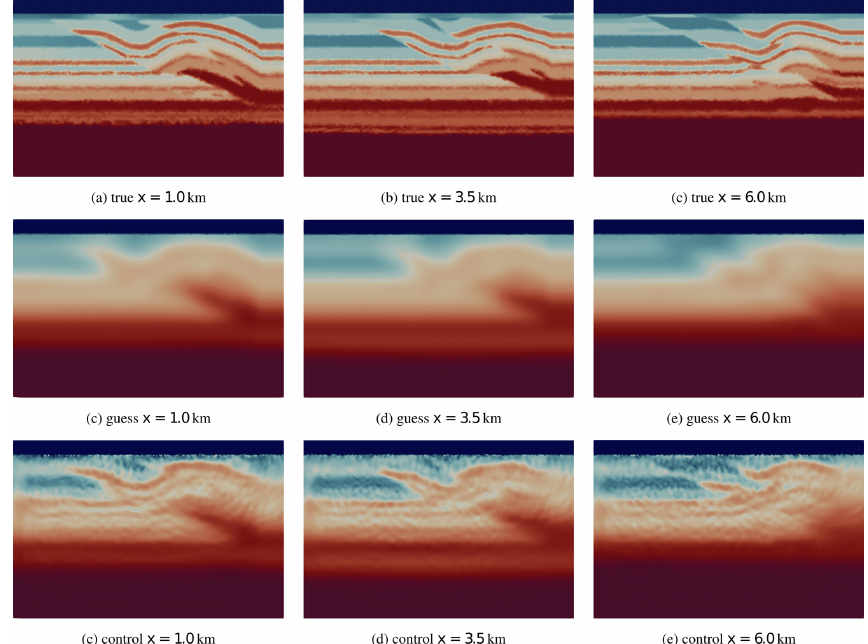
Figure 19. A comparison of cross-sectional slices along the x axis in the Overthrust3D experiment between the true model, guess model, and reconstructed wave field (control) after 100 FWI iterations.